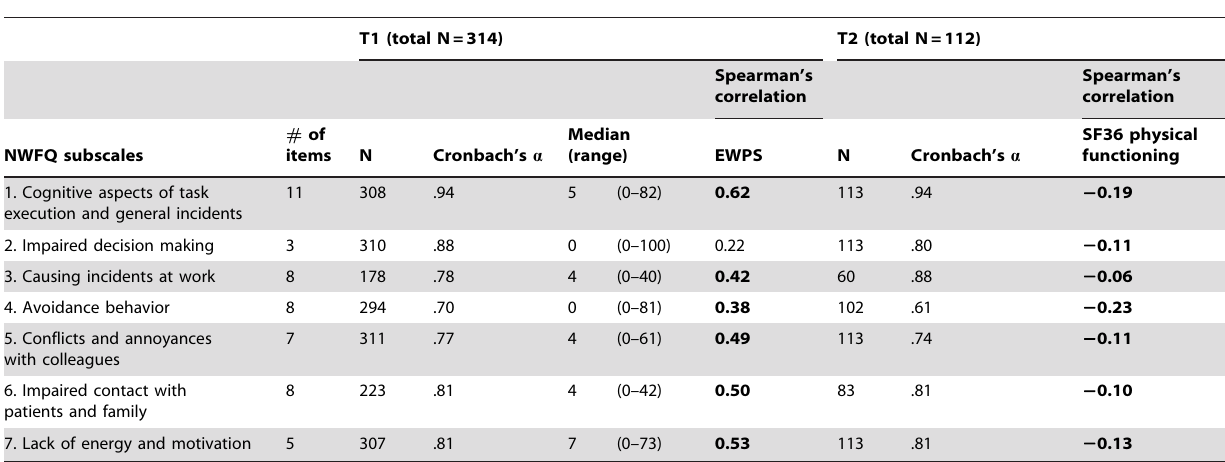
Table 3. Overview of subscale characteristics and correlations for the construct validity